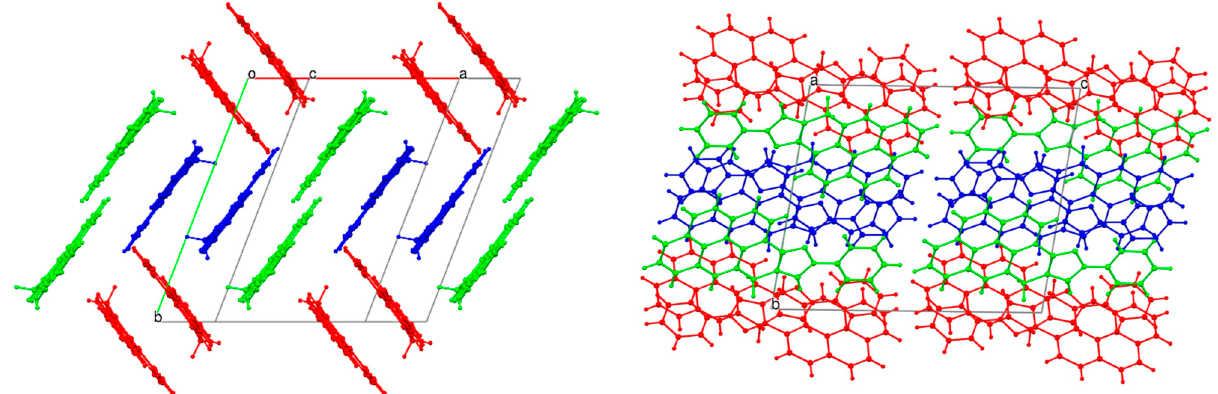
Figure 7. Crystal packing of compound 3 in selected directions (three crystallographically independ- ent molecules are highlighted in colors). Left: View in the direction parallel to the pyrene planes of all molecules, showing π ··· π stacked dimers; Right: View along [100] showing the layers separation along [001]. More details are provided in Supplementary Information.